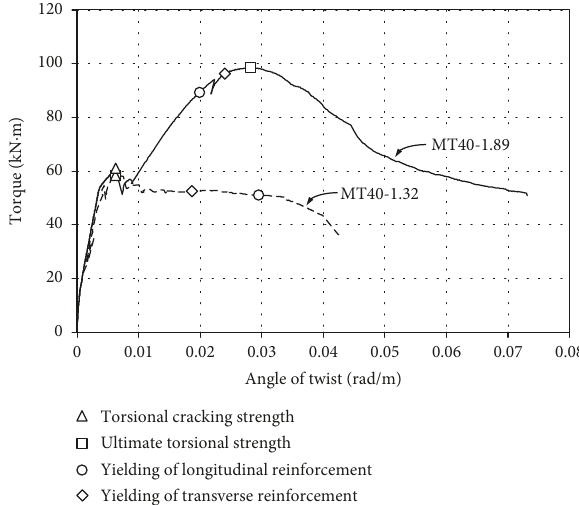
Figure 4: Torsional moment-twist of MT30 series.